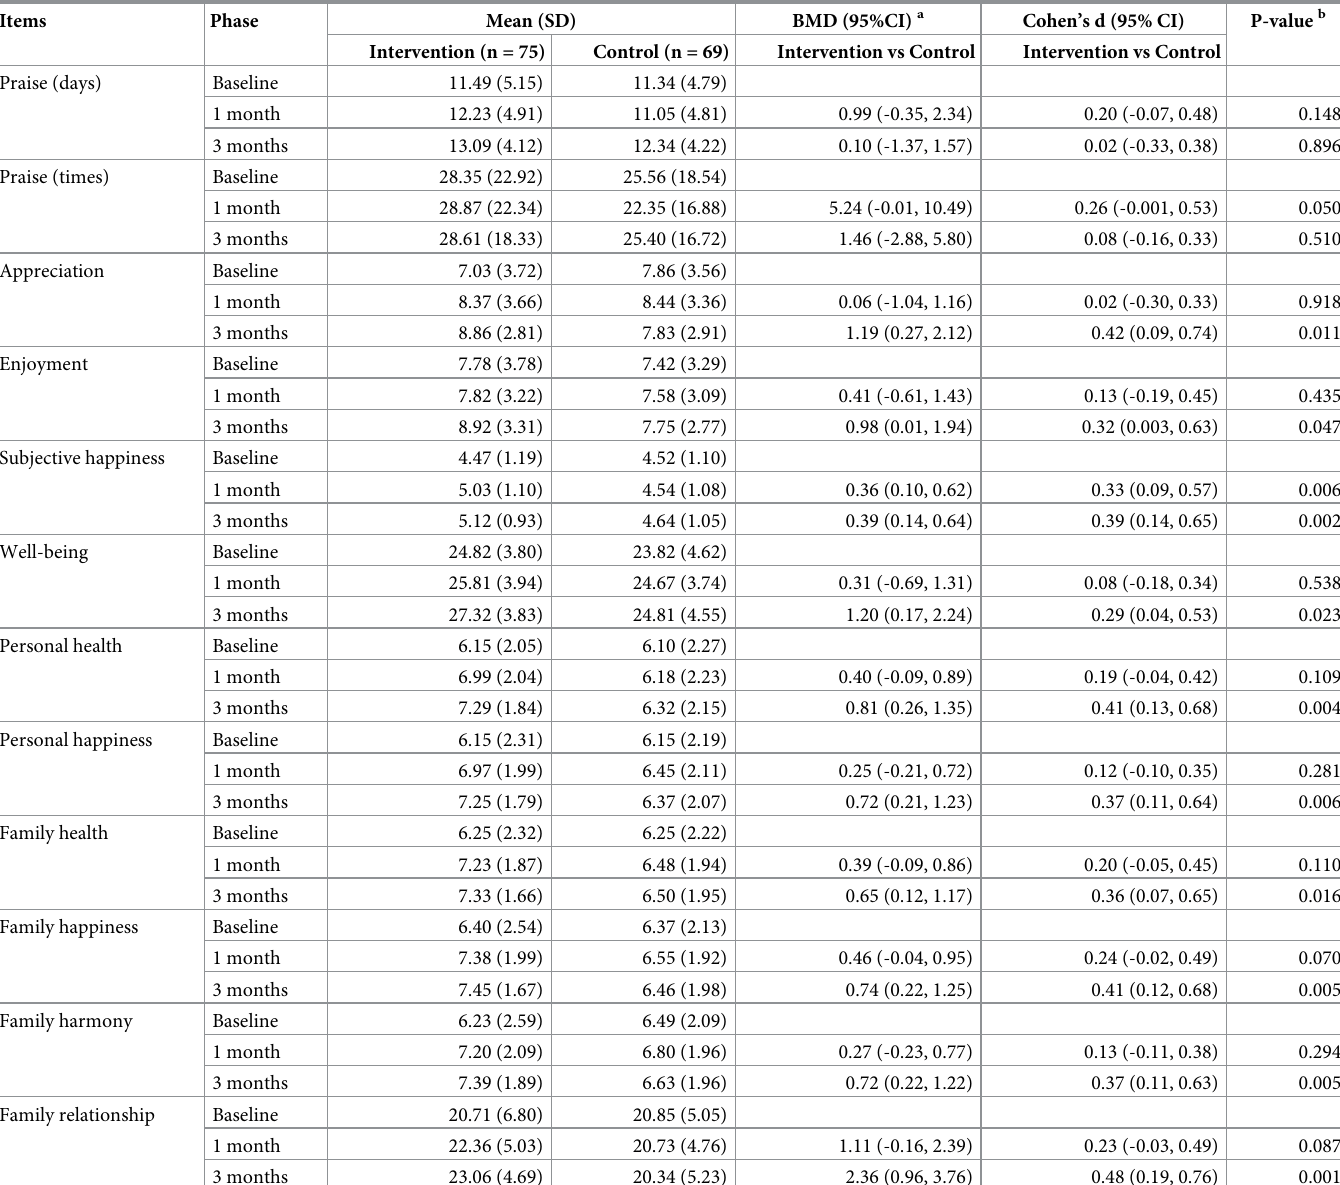
Table 2. The comparison between intervention group (n = 75) and control group (n =